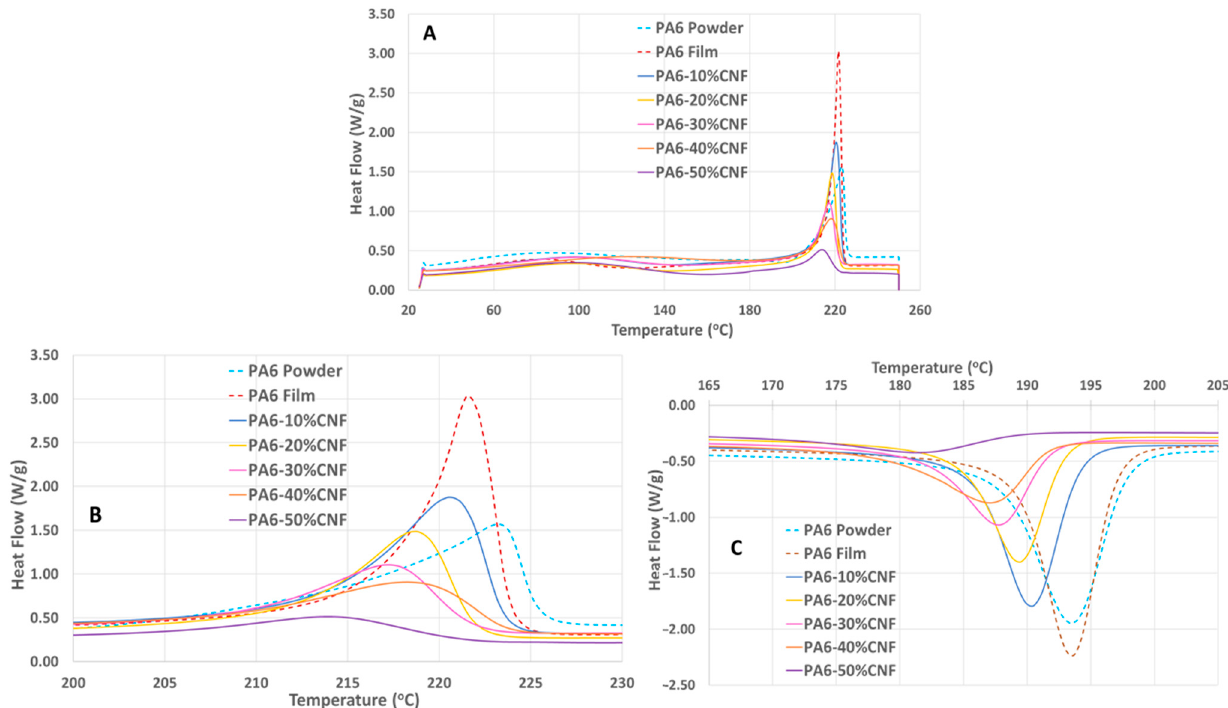
Figure 7. DSC thermograms: ( A ) heating cycle, ( B ) melting region, and ( C ) cooling region, all at a rate of 10 °C/min, for PA6 powder, PA6 film, and PA6-CNF nanocomposite films.